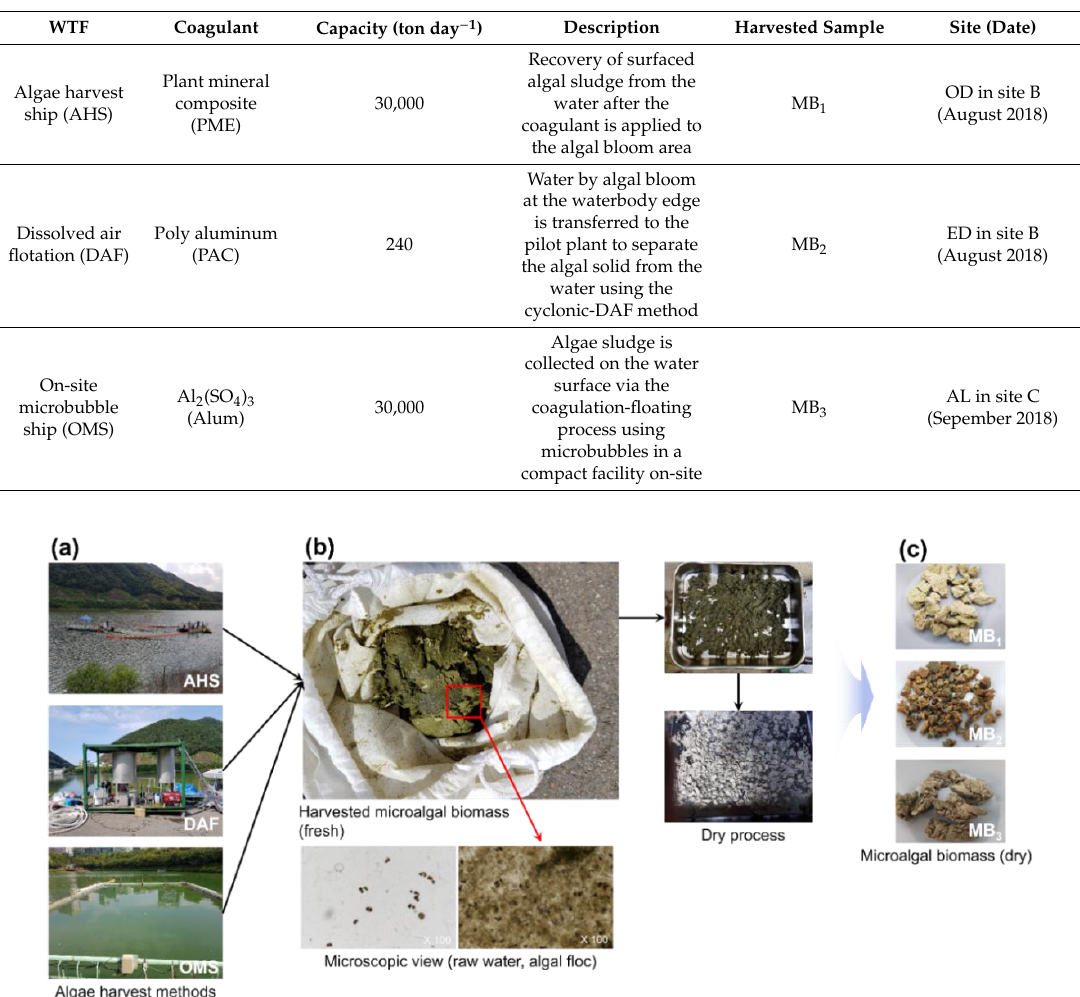
Figure 1. Procedures for harvesting freshwater MB samples in river and lake during algal bloom and pretreatment processes. ( a ) Algae harvesting methods in large quantities on the field sites (from the top; AHS, DAF, OMS), ( b ) Pictorial and microscopic view of harvested intact MB samples, and ( c ) Pictorial view of the dried MB samples (from the top; MB 1 , MB 2 , MB 3 ).